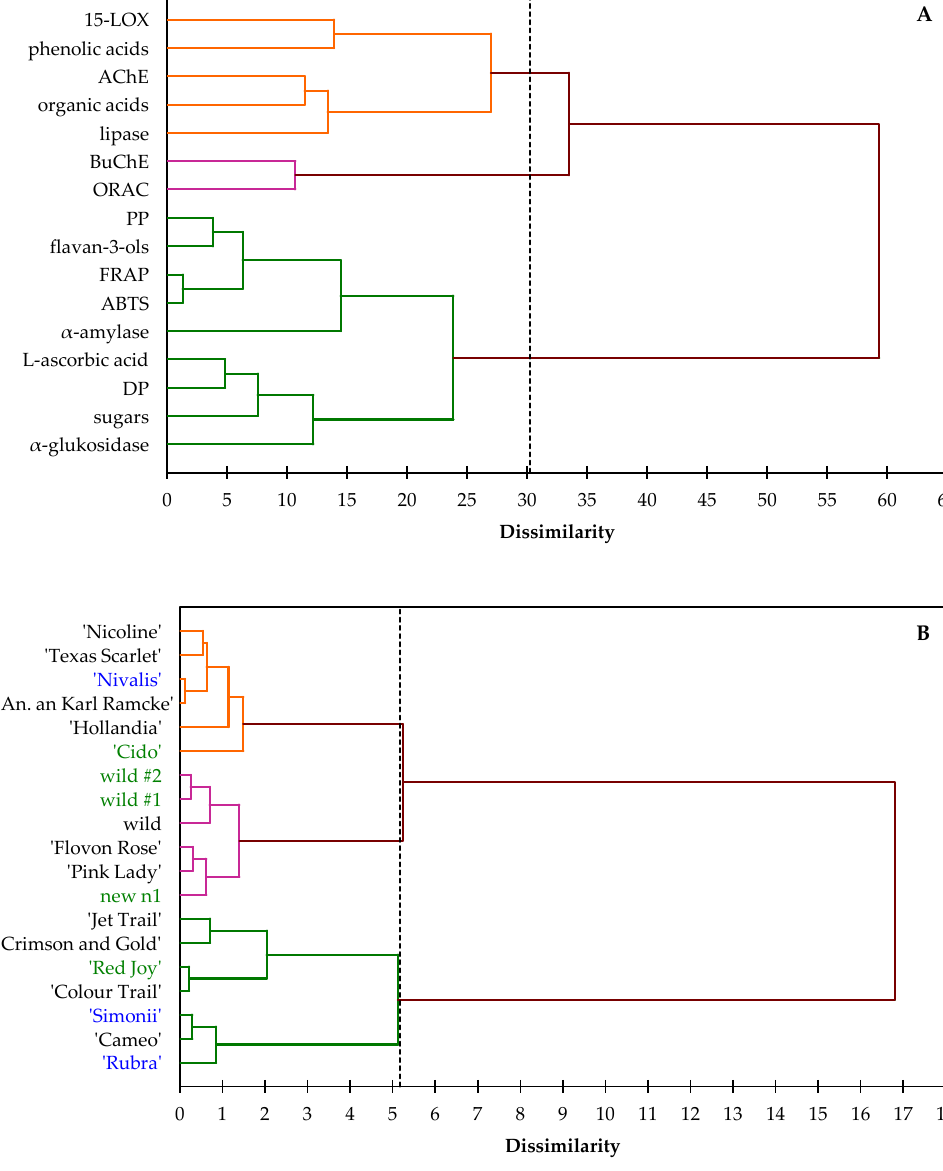
Figure 2. Dendograms of Agglomerative Hierarchical Clustering (AHC) analysis representing dissimilarity relationship of biological activieties and chemical compounds ( A ) and between studied cultivars ( B ) of Chaenomeles × superba (black), C. japonica (green) and C . speciosa (blue). PP – polymeric procyanidins; DP – degree of polimerization.